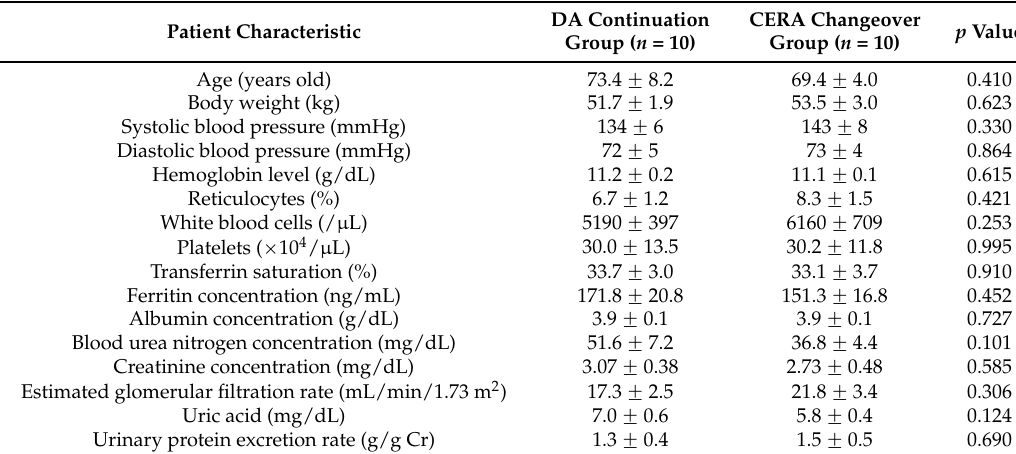
Table 1. Patient baseline characteristics.